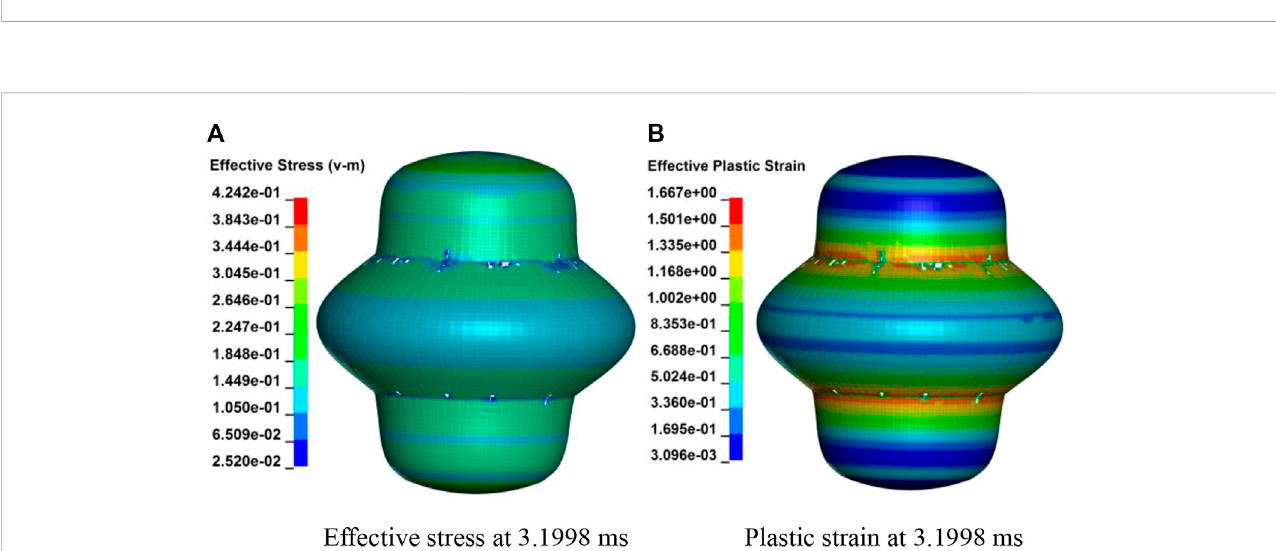
Fully-penetration pressure hull with two holes. (A) Effective stress at 3.1998 ms (B) Plastic strain at 3.1998